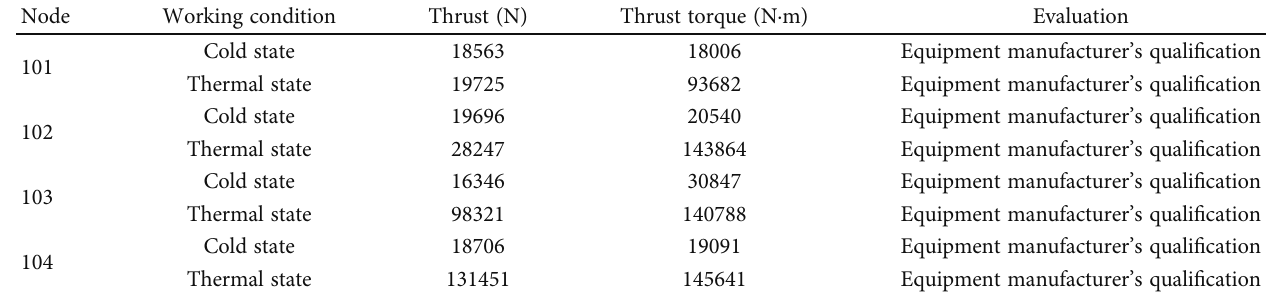
Table 7: Port thrust results.